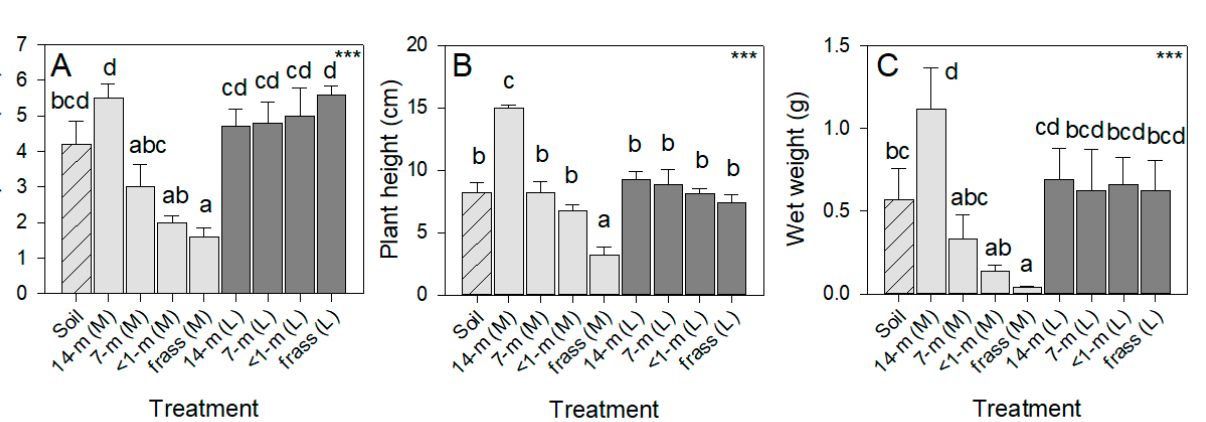
Plant wet weight (Figure 1E: F 8,72 = 7.540, p < 0.001) and the surface areas of cotyledons (Figure 3F: F 8,72 = 7.696, p < 0.001) and true leaves (Figure 3G: F 8,72 = 7.940, p < 0.001) were